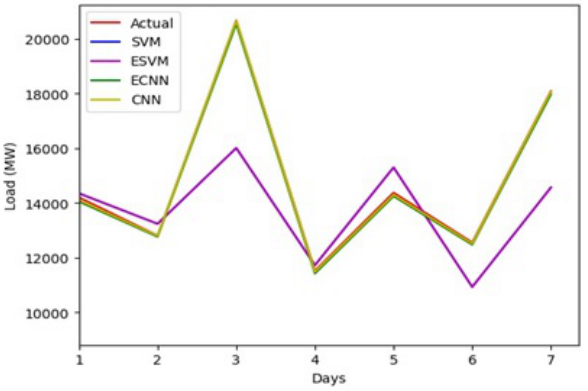
Figure 9. One week load forecasting.